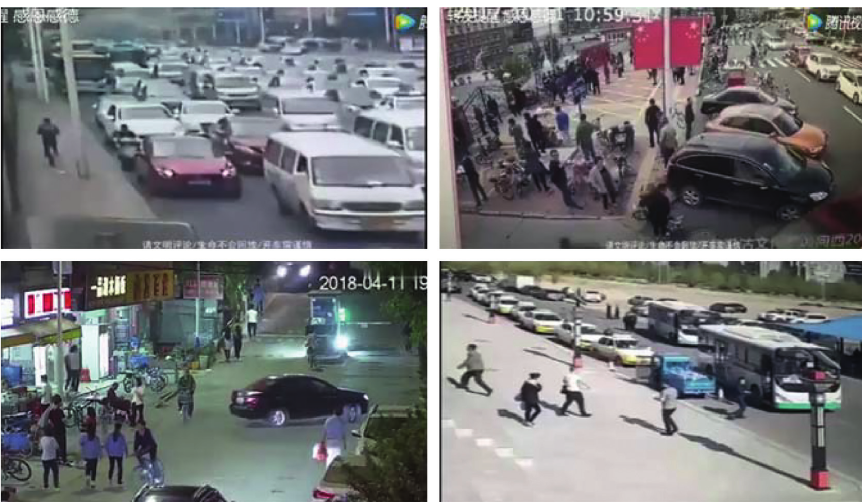
Figure 11: False-positive examples of model 6 (the best model).